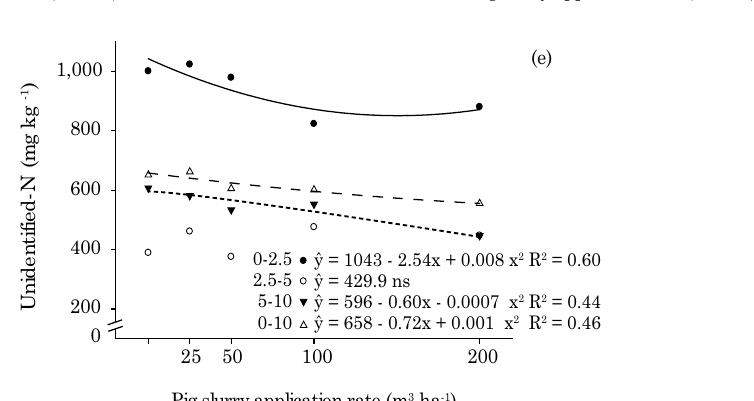
Table 6. nitrogen content in the leaf tissue of maize and oat subjected to 10 years of annual fertilization with mineral fertilizer (mF) and pig slurry (PS) at the application rates of 0 (control), 25, 50, 100, and 200 m -3 ha -1 in a no-till system. mean values of four replications Plant